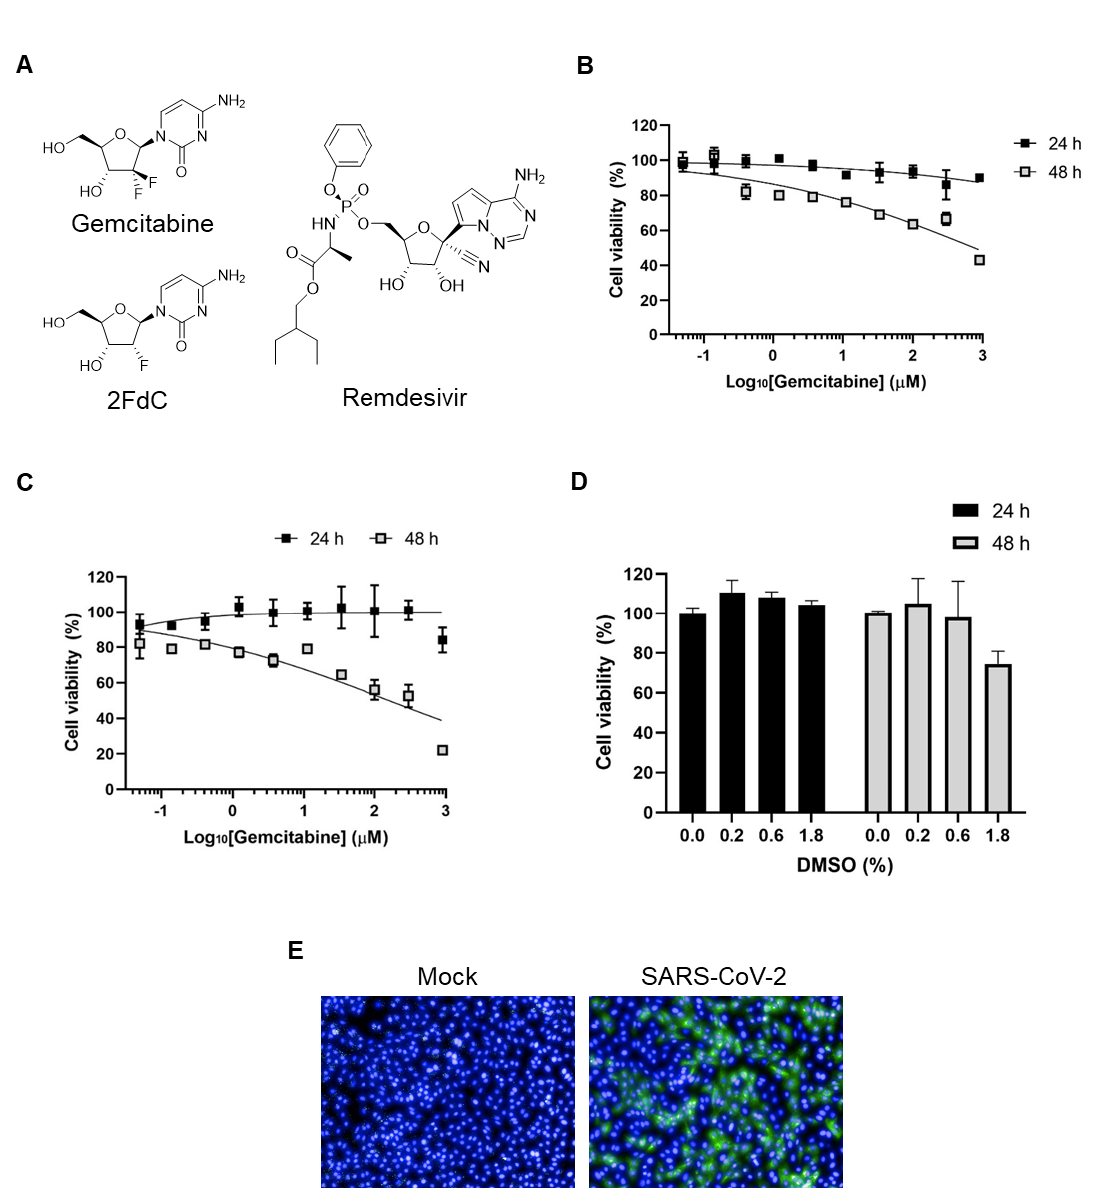
Figure 1. Chemical structures of the compounds tested and visualization of SARS-CoV-2-infected Vero cells. ( A ) Chemical structures of gemcitabine, 2FdC, and remdesivir. ( B ) MTT-based cytotoxicity assay of gemcitabine at different concentrations and time points. Vero cells were treated with increasing concentrations of gemcitabine for 24 h (black square) or 48 h (gray square). Percentage cell viability was measured by using MTT, in which mock-treated cells served as a control (100%). ( C ) Fluorescein diacetate-based cytotoxicity assay of gemcitabine. Vero cells were treated with increasing concentrations of gemcitabine for 24 (black square) and 48 h (gray square). Percentage cell viability was measured by addition of fluorescein diacetate, in which mock-treated cells served as a control (100%). ( D ) Fluorescein diacetate-based cytotoxicity assay of a delivery vehicle. Increasing concentrations of DMSO, 0.2, 0.6 and 1.8% ( v / v ), that were identically included in 100, 300 and 900 µ M gemcitabine shown in ( C ), were treated to Vero cells for 24 (black bar) and 48 h (gray bar). Values in ( B – D ) are means ± standard deviations from thee three independent experiments. ( E ) Visualization of SARS-CoV-2 infection. Vero cells were mock-infected (Mock) or infected with SARS-CoV-2 at a multiplicity of infection (MOI) of 0.02 for 24 h. Viral spike (S) protein was probed with mouse anti-S antibody and Alexa Fluor 488-conjugated goat anti-mouse antibody (green). Cellular nuclei were counterstained with DAPI (blue). Magnification ×20.